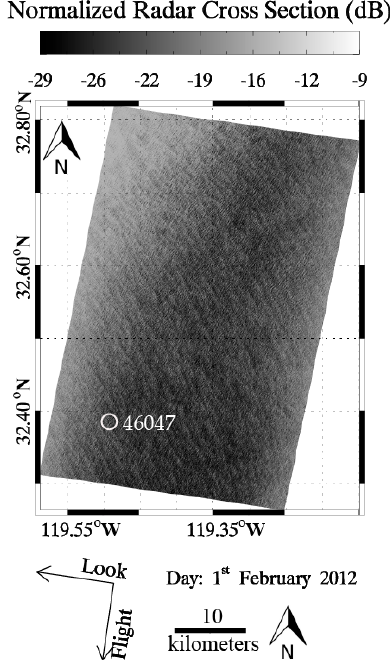
Figure 6. The image of HH-polarization TS-X image in StripMap mode acquired at 16:19 UTC on 1 February 2012, covering the NOAA in situ buoy (ID: 46047).